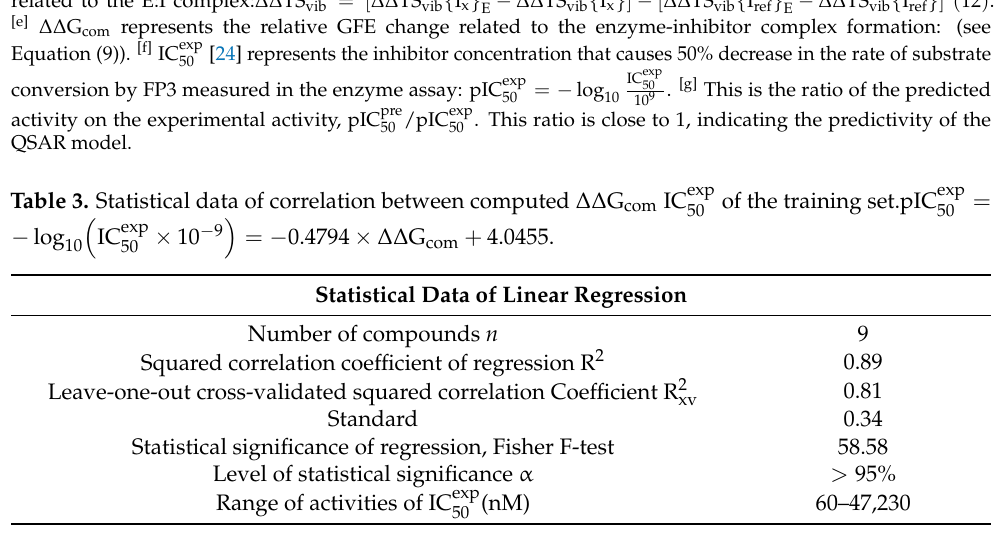
Table 3. Statistical data of correlation between computed ∆∆ G com IC exp